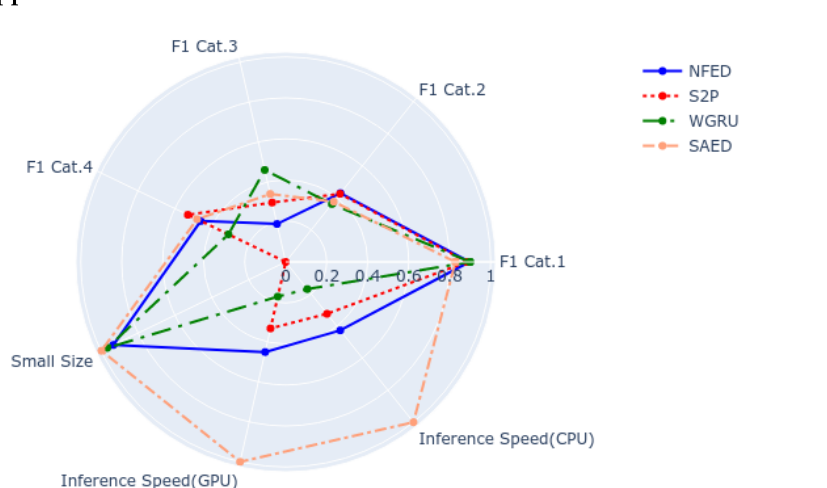
Figure A1. Diagram that summarizes the capabilities of the models to disaggregate a washing